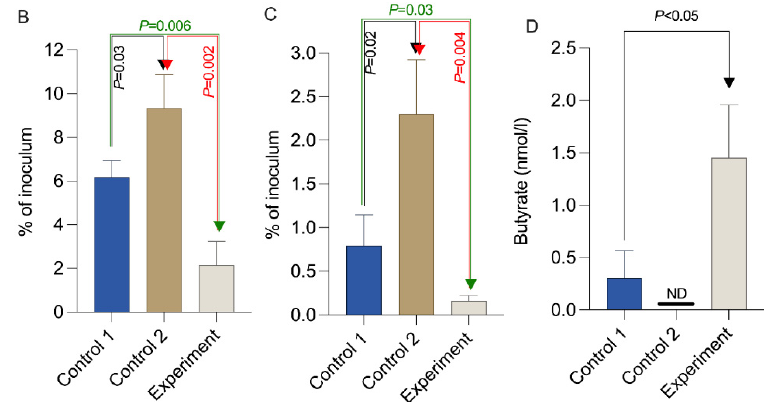
Figure 4. The effect of 0.5% Aq and F. prausnitzii in preventing V. parahaeomolyticus A3 infection of SGP cells. Panel ( A )—Experimental design (Created with Biorender.com). Panel ( B )—Adhesion to SGP cells by V. parahaeomolyticus A3; Panel ( C )—Invasion of SGP cells by V. parahaeomolyticus A3. Panel ( D )—Butyrate released in the culture supernatant during infection. The results are expressed as percentages of the initial inoculum. P values are indicated on the graphs (Student’s t ‐ test) and the error bars represent the standard deviation of means from three different experiments, each con ‐ taining triplicate samples.